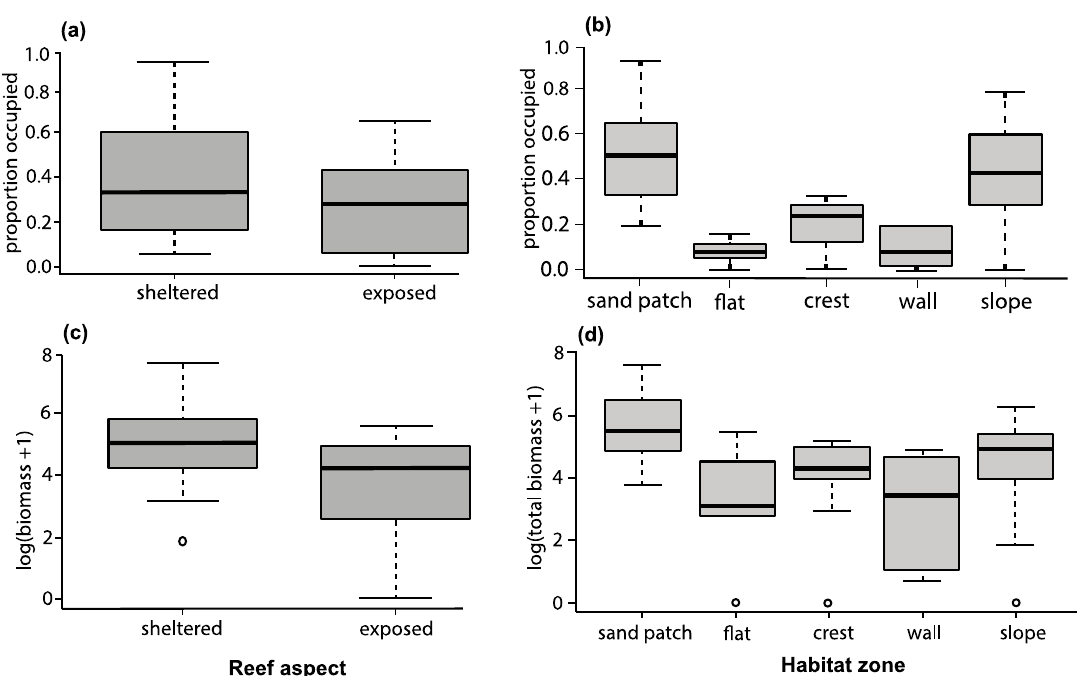
Figure 2. Boxplots (horizontal lines show median; boxes indicate 25th and 75th percentiles; vertical dotted lines show range; data points show outliers) of colonies occupied (reef seascape) ( a , b ) and damselfish’s biomass (log + 1) abundance ( c , d ) on five species of branching coral ( Acropora intermedia , Acropora spathulata , Pocillopora damicornis , Seriatopora hystrix , and Stylophora pistillata ) in relation to aspect category (exposed or sheltered) and reef habitat (sand patches, flat, crest, wall, and slope / base).